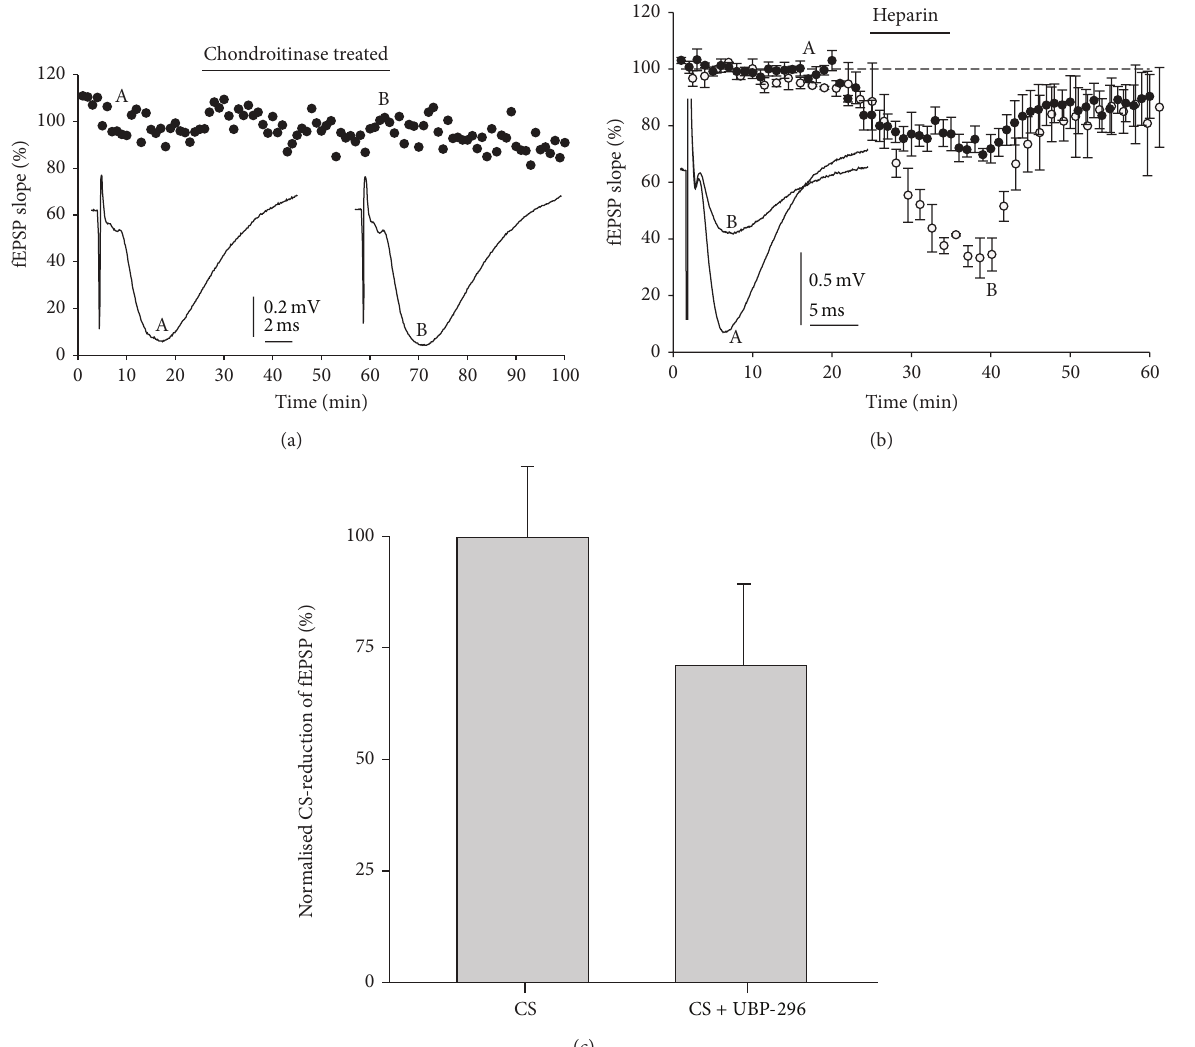
Figure 5: Effects of chondroitinase ABC, heparin, and UBP-296 on synaptic transmission. (a) Time-course of fEPSP slope recorded in the presence of CS (300 𝜇 M) treated with chondroitinase during the time indicated by the top horizontal bar. Insets A and B represent the original traces of fEPSPs in the points A and B of the time-course curve. (b) fEPSP recorded in the presence of heparin (100 𝜇 M, close circle; 300 𝜇 M, open circle). Insets represent the original traces in the points A and B of the time-course curve (heparin 300 𝜇 M). (c) Normalised averaged depression of fEPSP observed after application of 300 𝜇 M CS in control slices and others pretreated with UBP-293 (30 𝜇 M). The bars represent themean ± SEMofthosefEPSPsrecordedduringthe35minutesofdrugapplication.Notethatnostatisticaldifferenceswereobserved.( 𝑛 = 11